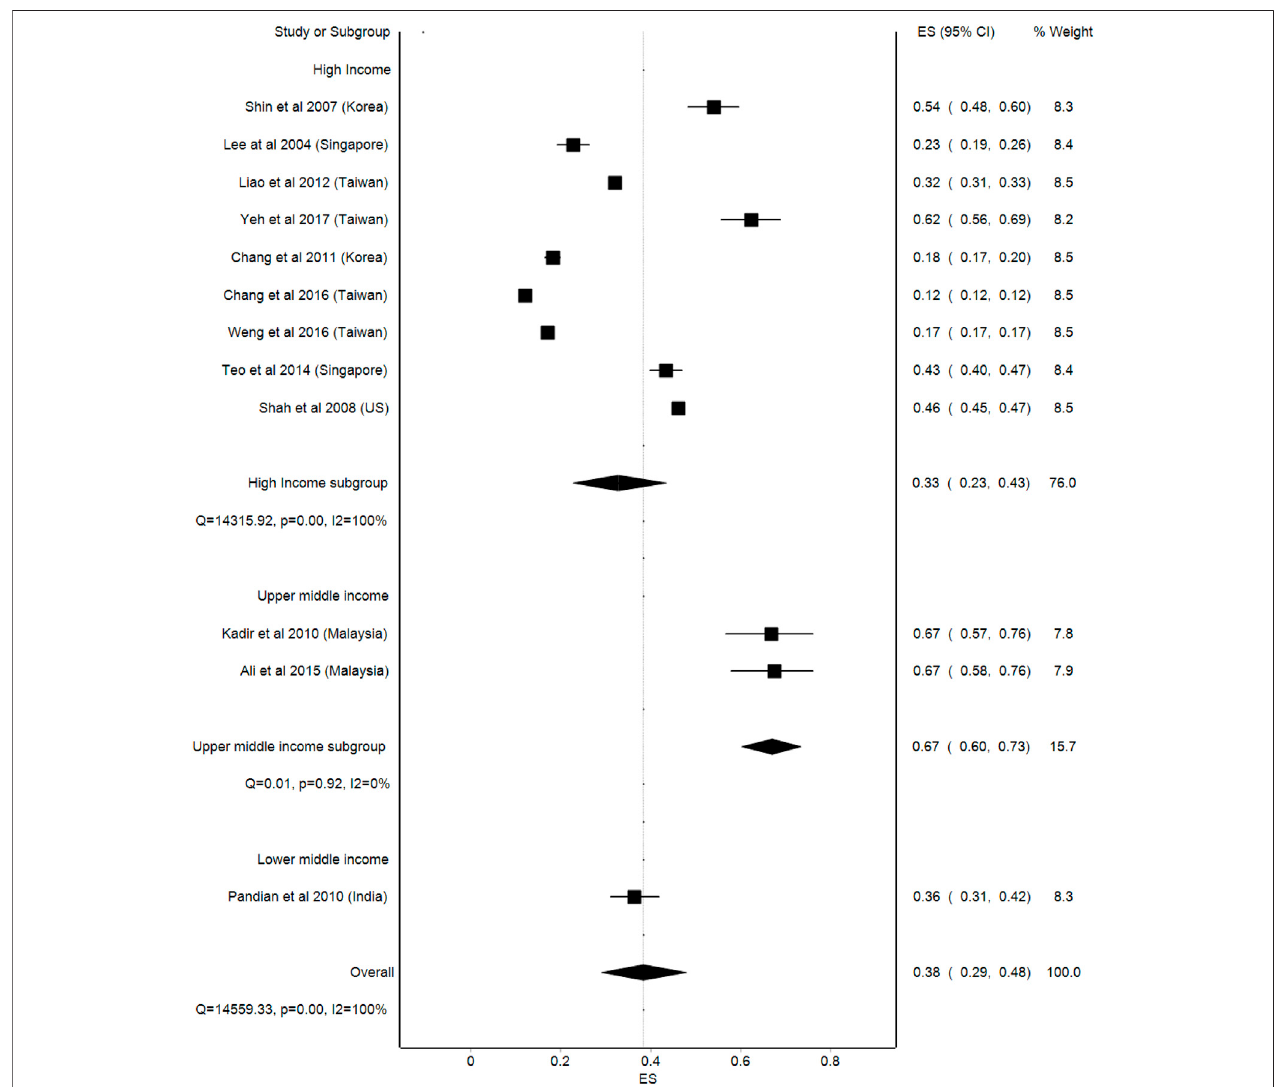
FIGURE 3 | Prevalence proportion of CAM use by level of income.